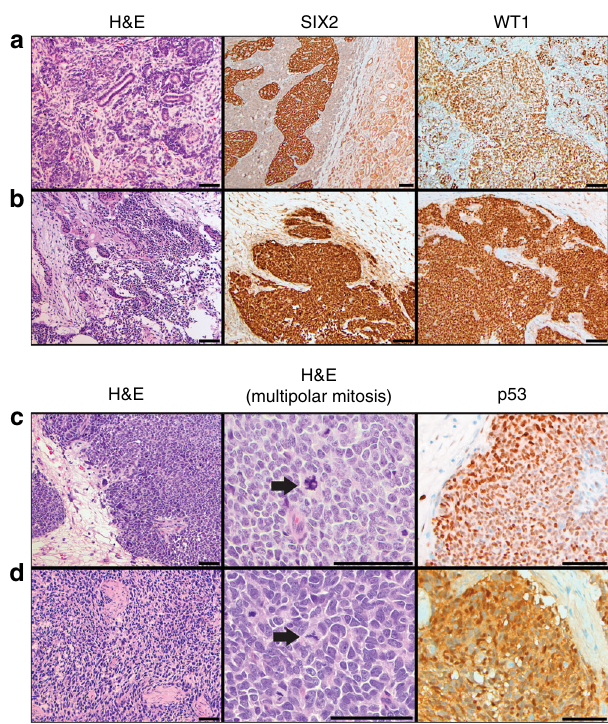
Fig. 2 WTPDX recapitulate histologic and molecular phenotypes of primary tumors. Paired favorable-histology, triphasic primary Wilms tumor (WT) a and WTPDX b corresponding to case KT-45 are shown in the top two rows. WTPDX b maintain the epithelial, stromal, and blastemal triphasic histology of primary WT a . WTPDX maintain blastemal SIX2 expression (middle) and WT1 expression (right) b compared with the primary WT a . Paired unfavorable-histology (diffuse anaplasia) WT c and WTPDX d corresponding to case KT-60. WTPDX d maintain the hyperchromatic, large nuclei, and atypical multipolar mitoses (arrows) of the primary WT c